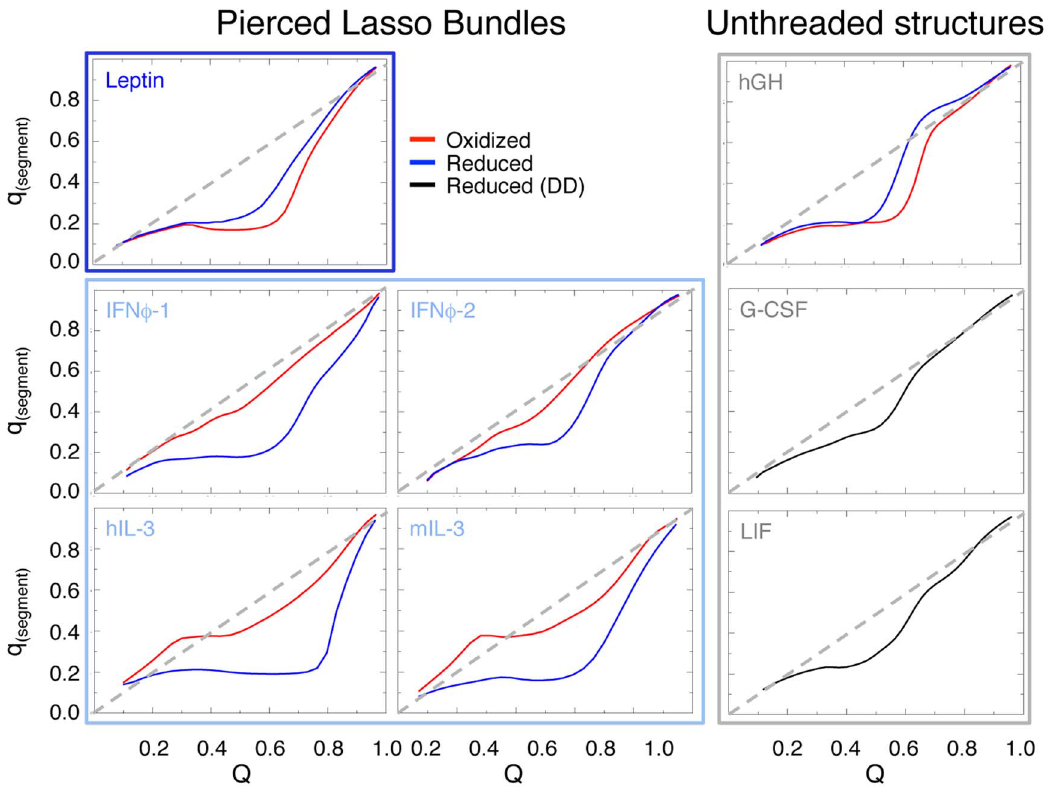
Figure 4. Probability of the formation of helix A. The plot shows data for Q (a measure of nativeness, between 0–1) versus q (segment) (formation of a particular secondary structure, in this case helix A). The plots display data for reduced (blue) and oxidized (red) protein in the case of the PLBs and the reduced state (black, DD) for the unthreaded proteins (see method section for a full description). The plots are grouped in three boxes according to position in sequence of the covalent loop, dark blue for the C-terminal covalent loop, light blue for the N-terminal covalent loop and grey for the unthreaded proteins. The plots show that the formation of helix A is a late event on the folding landscape as it starts to build its contacts at high Q. The diagonal dashed grey line shows where q (segment) is tracking the overall folding progress. A significant shift is seen between reduced and oxidized N-terminal PLBs where the oxidized state folds faster than the reduced state.